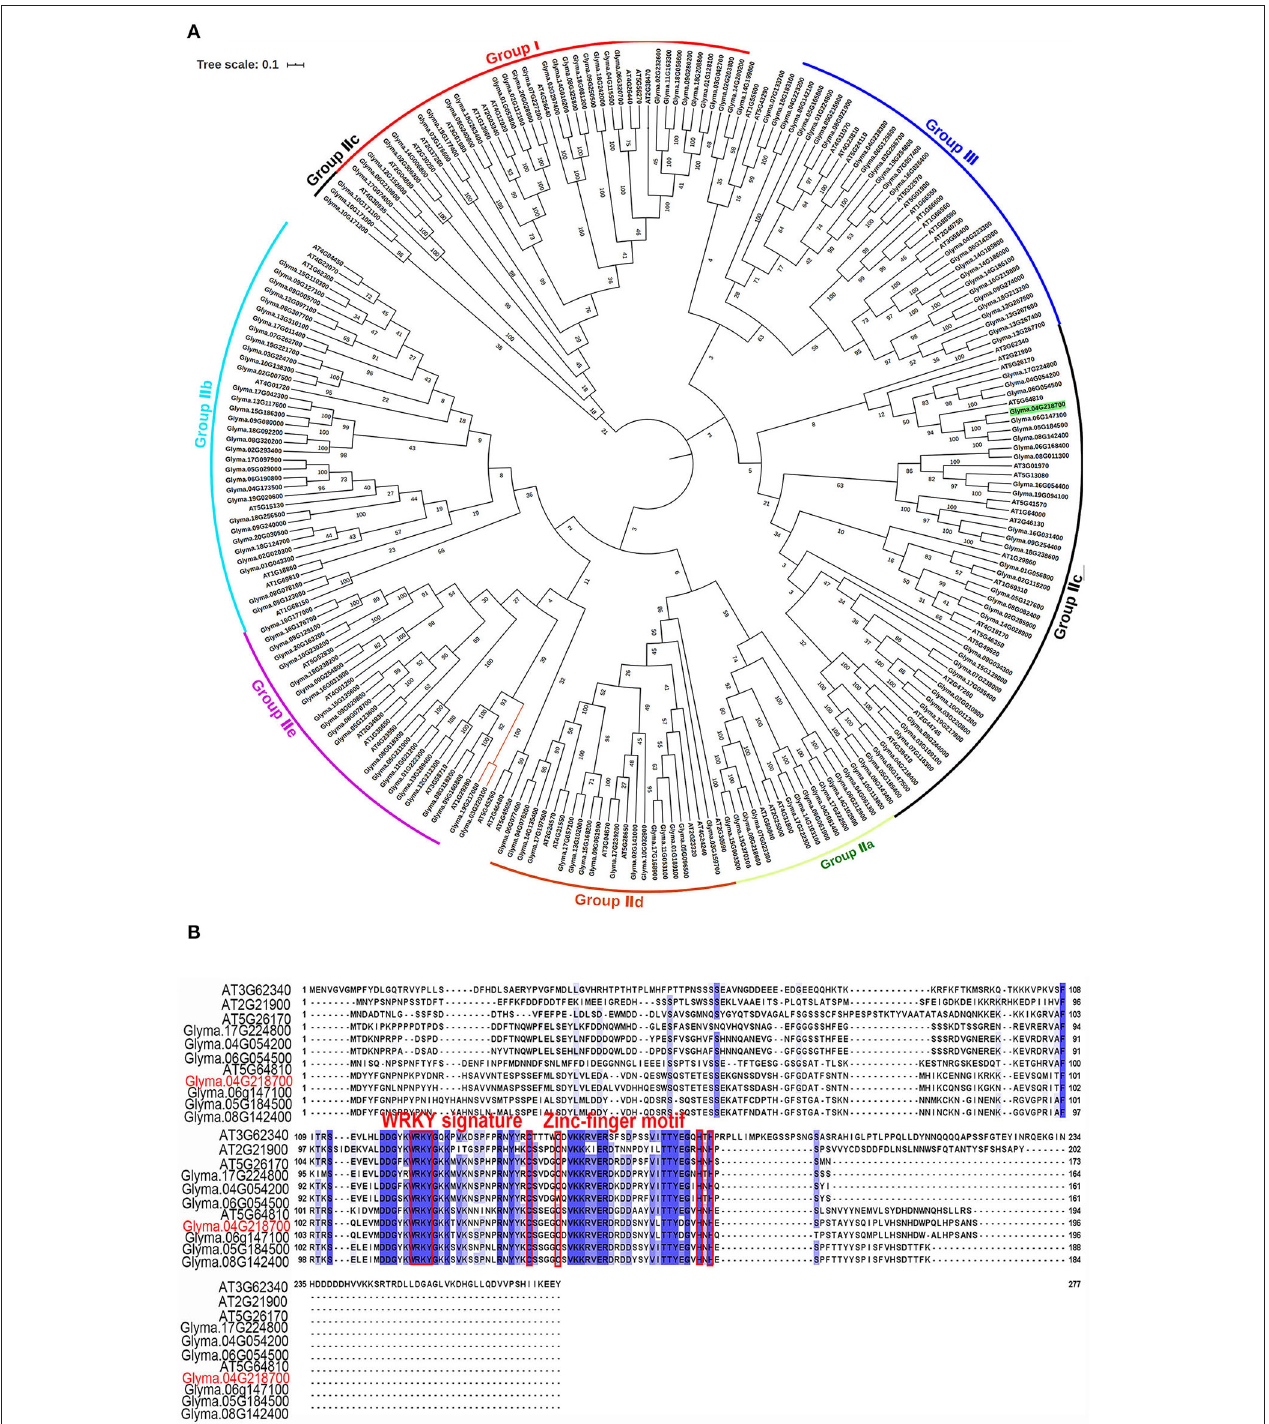
FIGURE 1 | Bioinformatics analysis of the GmWRKY21 gene. (A) Phylogenetic tree was constructed to analyze GmWRKY21 and WRKY proteins in soybean and Arabidopsis by the neighbor-joining method using the software of MEGA X. We selected 177 and 71 WRKT family genes in soybean and Arabidopsis , respectively ( Supplementary Table 1 ). The amino acid sequences and the accession numbers of WRKY proteins from soybean and Arabidopsis were obtained from the databases of NCBI (https://www.ncbi.nlm.nih.gov/). (B) Multiple sequence alignment of genes belonged to the same branch of GmWRKY21 from the phylogenetic tree in (A) . Red box highlights the WRKY domains and the zinc-finger motifs.